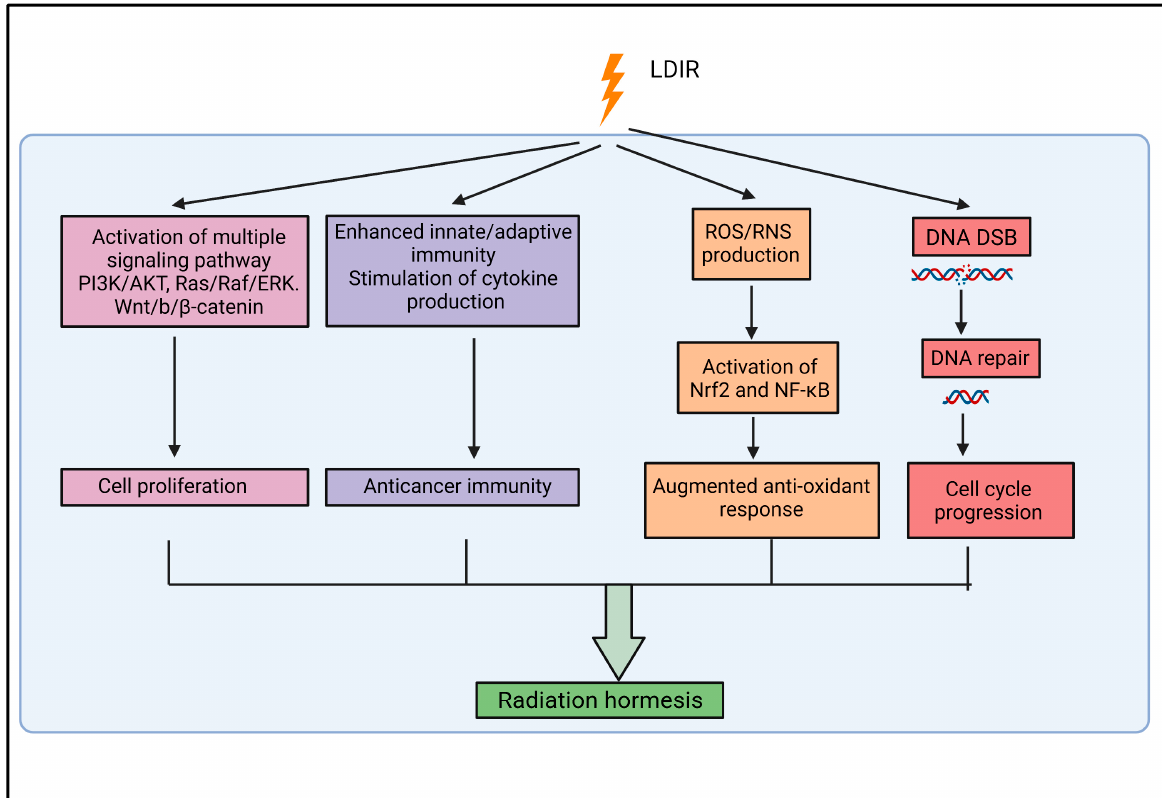
Figure 1. Multiple mechanisms through which LDIR induces hormesis. (RNS, reactive nitrogen species; DSB, double-stranded break) .